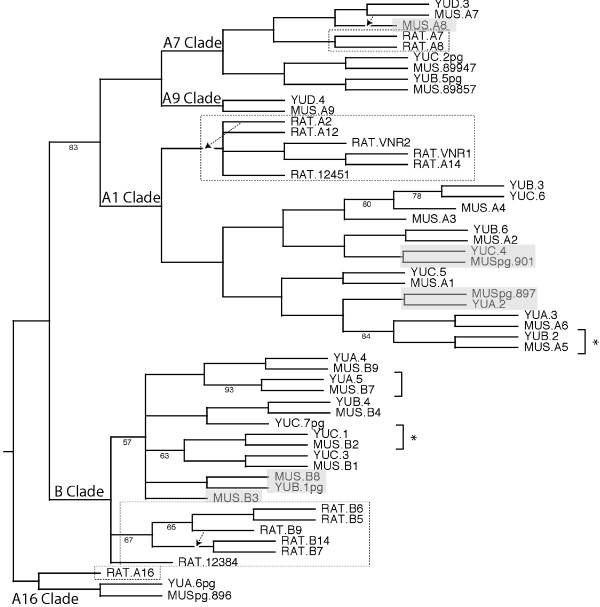
V1R gene tree. Distance tree produced using 56 codon-aligned V1R sequences (906 nucleotides length) from mouse (musculus V1Rs denoted with "MUS" prefix; spretus V1Rs denoted with "YU" prefix) and rat ("RAT" prefix; dotted boxed clades). Pseudogenes are denoted by "pg" in their names. Musculus-spretus orthologous pairs in which one species encodes an intact V1R and the other species encodes an apparent pseudogene are shaded. Deleted V1Rs in one species but not the other are also shaded. Brackets with asterisks denote the two orthologous gene pairs apparently subject to adaptive selection (dS/dN < 1; see text), and the bracket without asterisk denotes the one orthologous gene pair apparently subject to gene conversion (Fig. 2). From this phylogeny, we infer that the rodent ancestor had five V1R genes: a homolog to rat A16, a homolog to mouse A1, a homolog to mouse A9, a homolog to mouse A7, and a B-like homolog. Bootstrap values (1000 replicas) for nodes <95% are indicated. Dashed lines with arrows show different locations of the MUS.A7, RAT.A2, and RAT.B9 branches in a parsimony bootstrap tree (1000 replicas) (not shown).